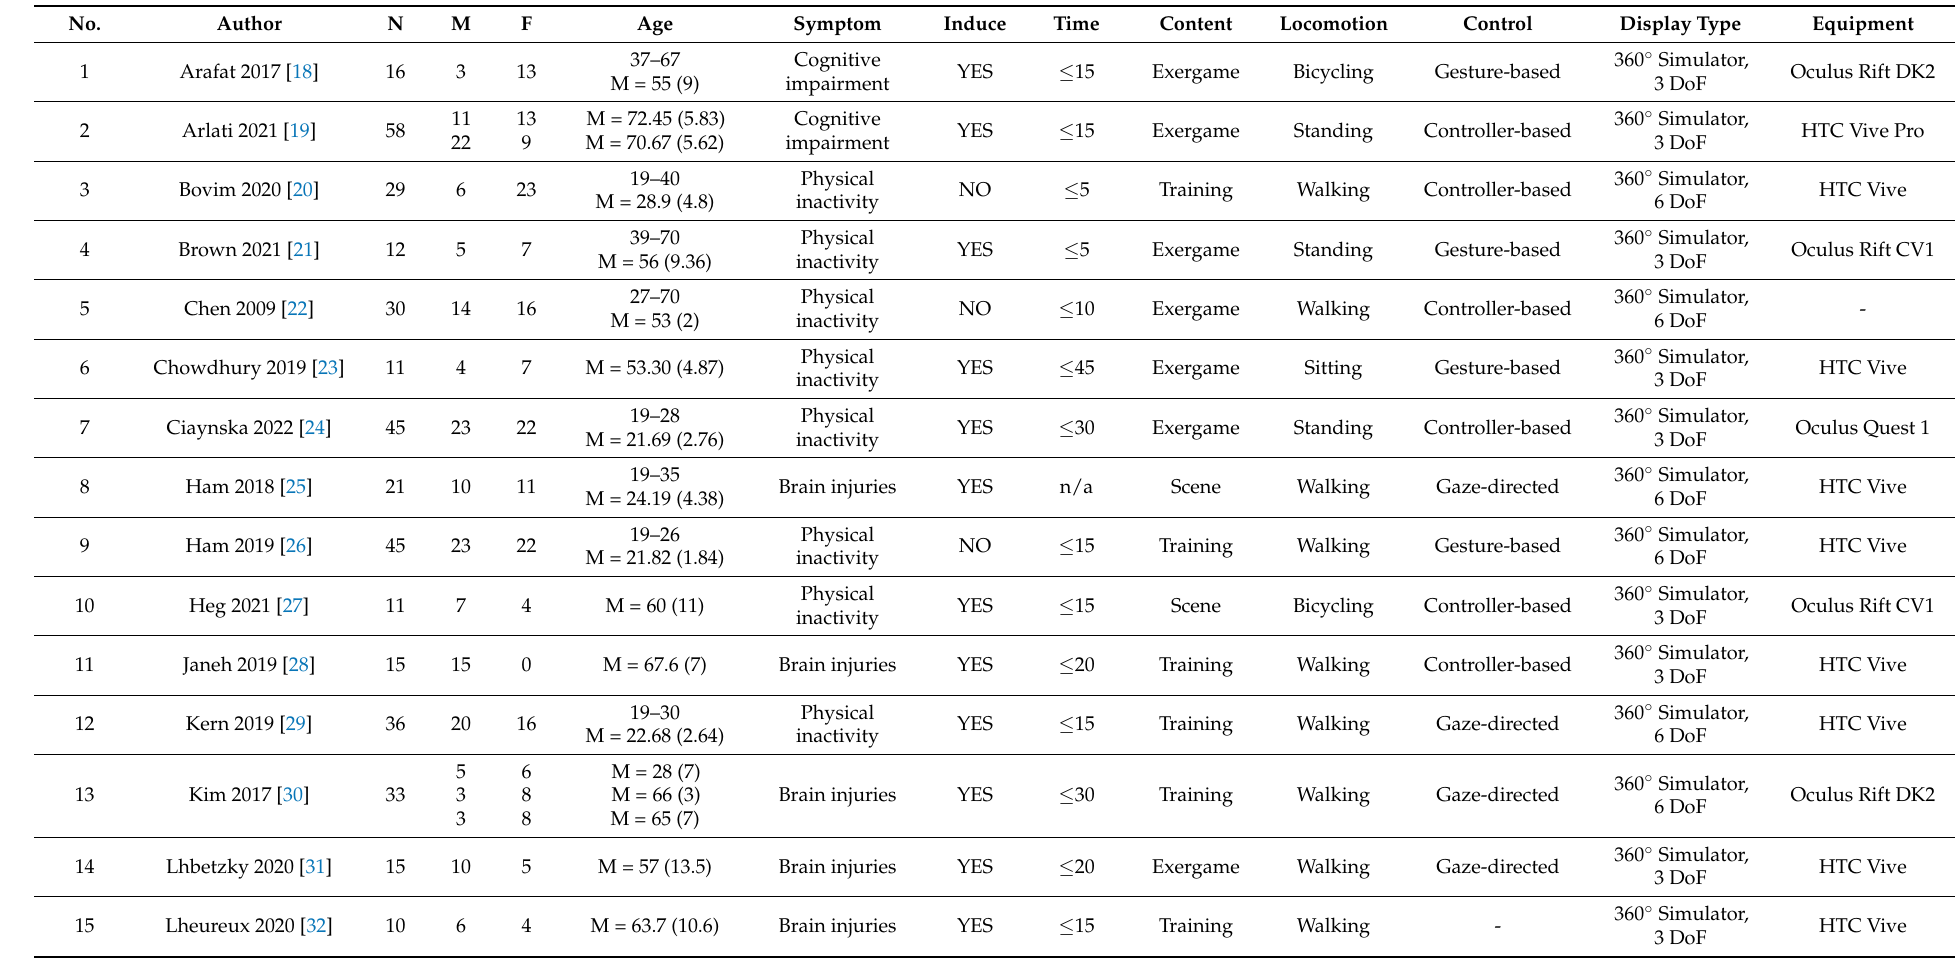
Table 2. Summary of included papers. N denotes number. M denotes male. F denotes